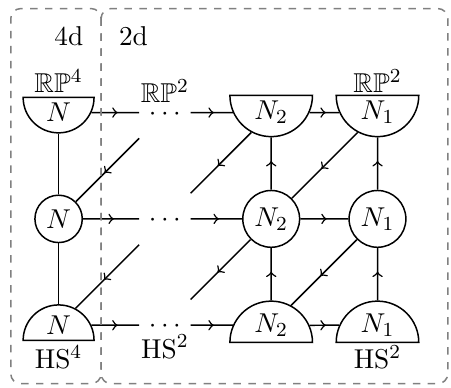
Figure 5 . M5 brane defect described as a 2d N = (2 ; 2) quiver gauge theory (nodes are U( N i ) gauge groups, arrows are bifundamental chiral multiplets) coupled to the 4d N = 2 theory (nodes are SU( N ) gauge groups, edges bifundamental hypermultiplets). The defect breaks SU( N ) to S [U( N 1 ) (cid:2) U( N 2 (cid:0) N 1 ) (cid:2) (cid:1) (cid:1) (cid:1) (cid:2) U( N (cid:0) N M (cid:0) 1 )] on its support. In the example depicted here, one of the 4d vector multiplets is Z 2 identi(cid:12)ed to live on RP 4 , and the 2d (cid:12)elds that implement its breaking (the (cid:12)rst row of nodes and arrows) likewise live on RP 2 ; another vector multiplet lives on HS 4 and the last row of 2d (cid:12)elds on HS 2 . The quiver description itself will be studied in [65]. momentum this could plausibly correspond to Wilson-’t Hooft lines joining antipodal points in RP 4 , and for a non-degenerate one it could be a domain wall supported on a lens space b S 3 = Z (cid:26) RP 4 2 b b